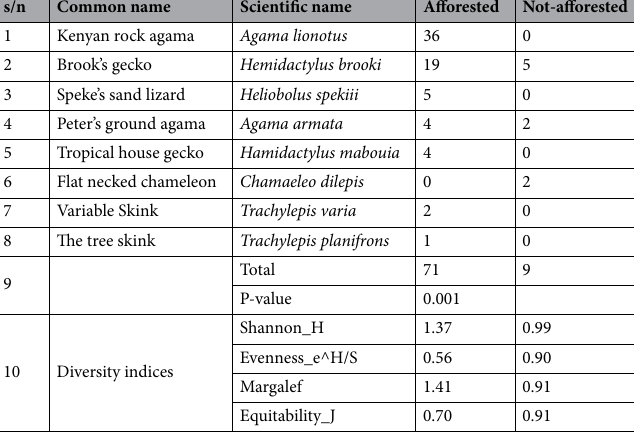
Table 5. Species of Lizard in afforested and non-afforested